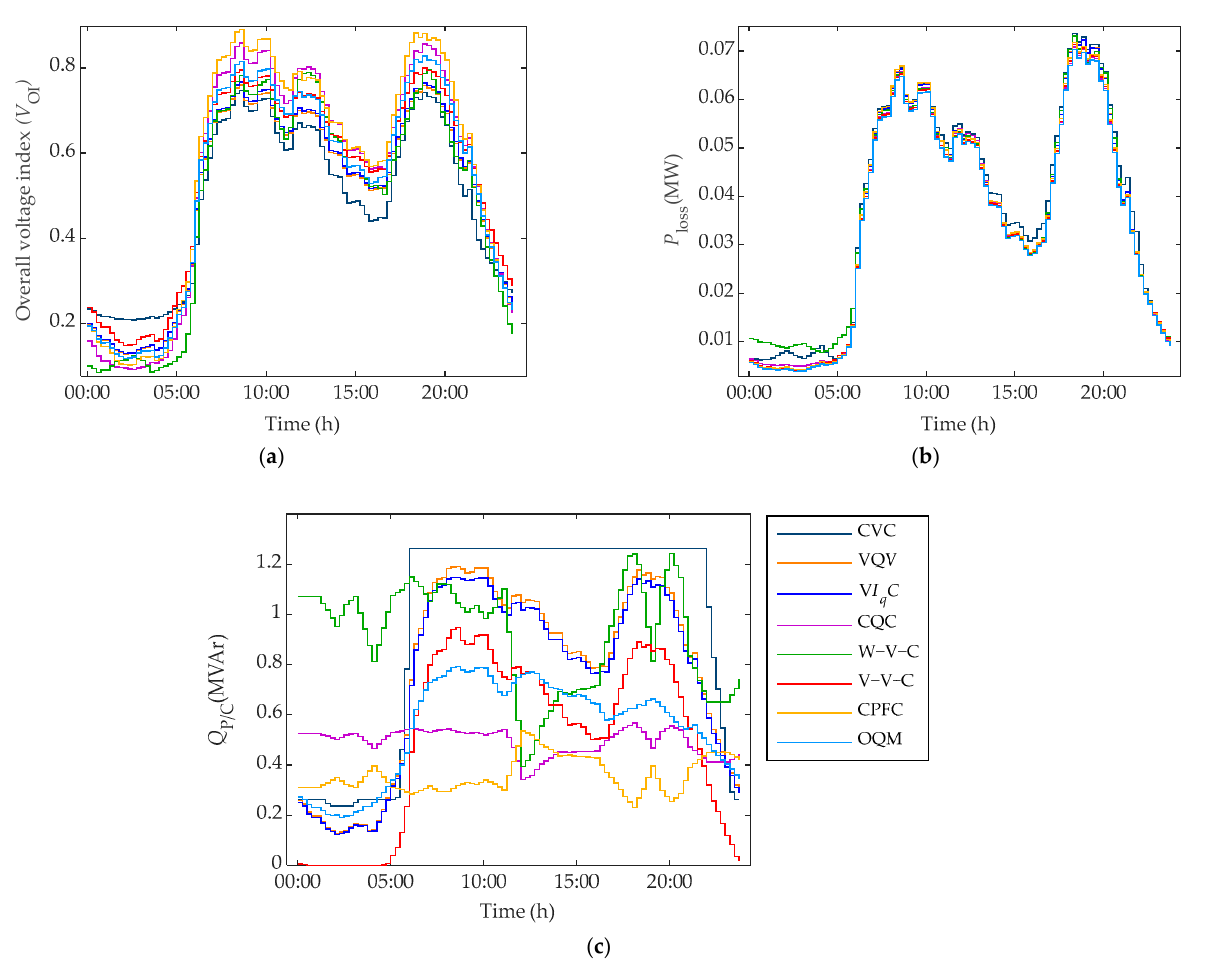
Figure 10. Day-ahead steady-state performance of microgrid by enabling the local and the optimal-centralised reactive power management at the smart converters using 15-min resolution: ( a ) Overall voltage index ( V OI ) ( b ) Active power losses ( P loss ); ( c ) reactive power produced by the DER.